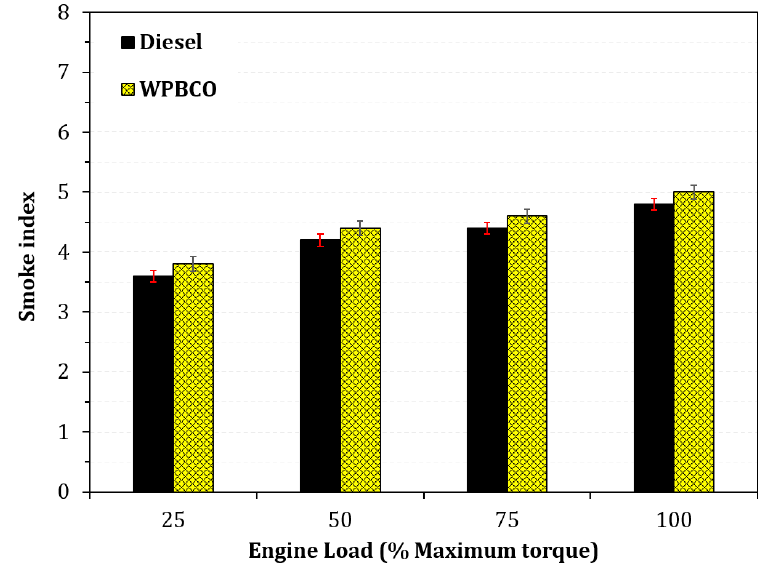
Table 8. Difference of PM – loaded filter weight for diesel fuel and WPBCO.